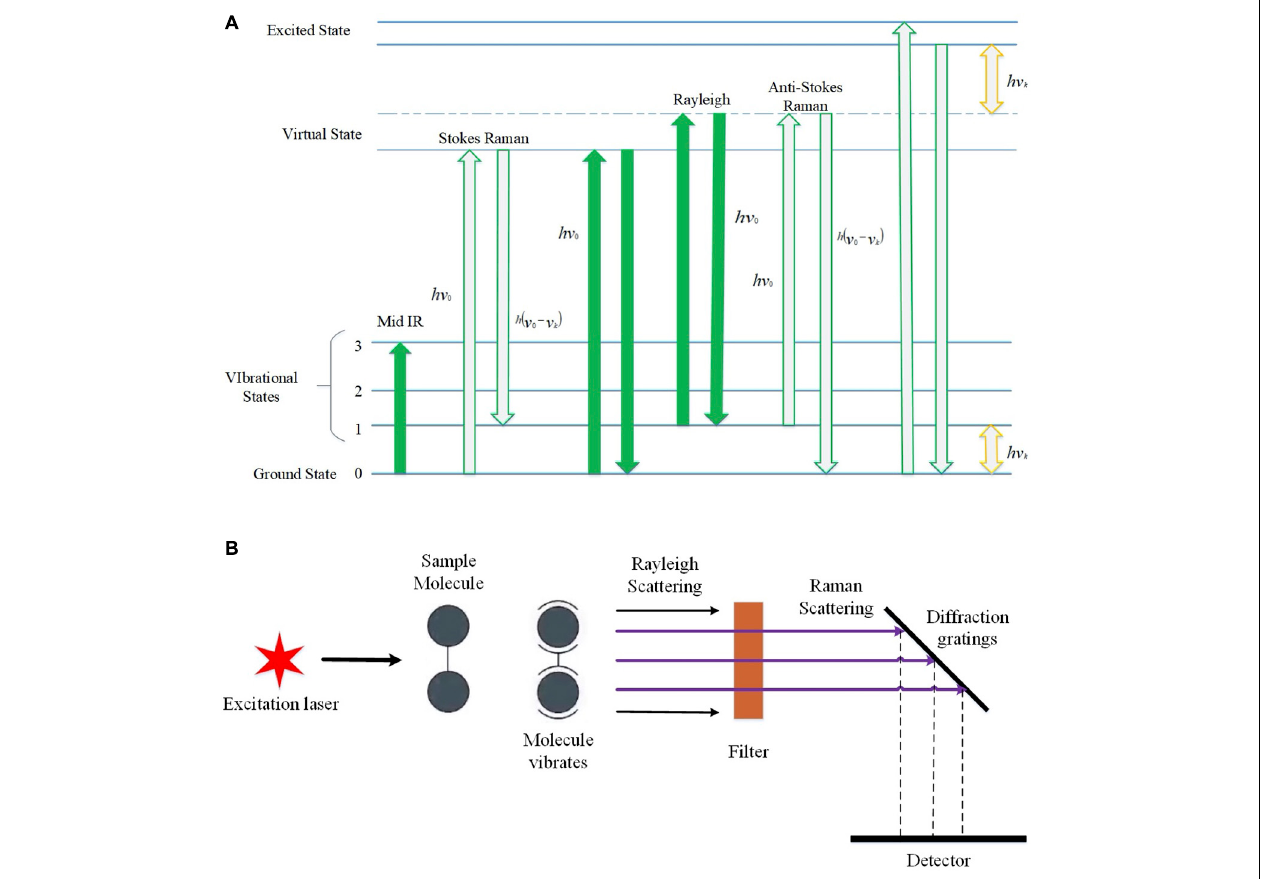
FIGURE 1 | Schematic illustration of the basic principles of Raman effects and the brief architecture of Raman spectroscopy. (A) Raman spectrum energy level diagram, which shows the transition process of infrared light irradiation, Stokes rays, anti-Stokes rays, Rayleigh scattering, and Raman scattering. hv irradiation energy; E , ground state; E , vibration excited state; E and E , excited virtual state. (B) Schematic diagram of Raman spectroscopy. After the 0 1 0 + hv 0 1 + hv 0 incident light is irradiated, the molecules reach an excited state. The light of different frequencies during the scattering process is Raman scattering, which is reflected on the grating and captured by the